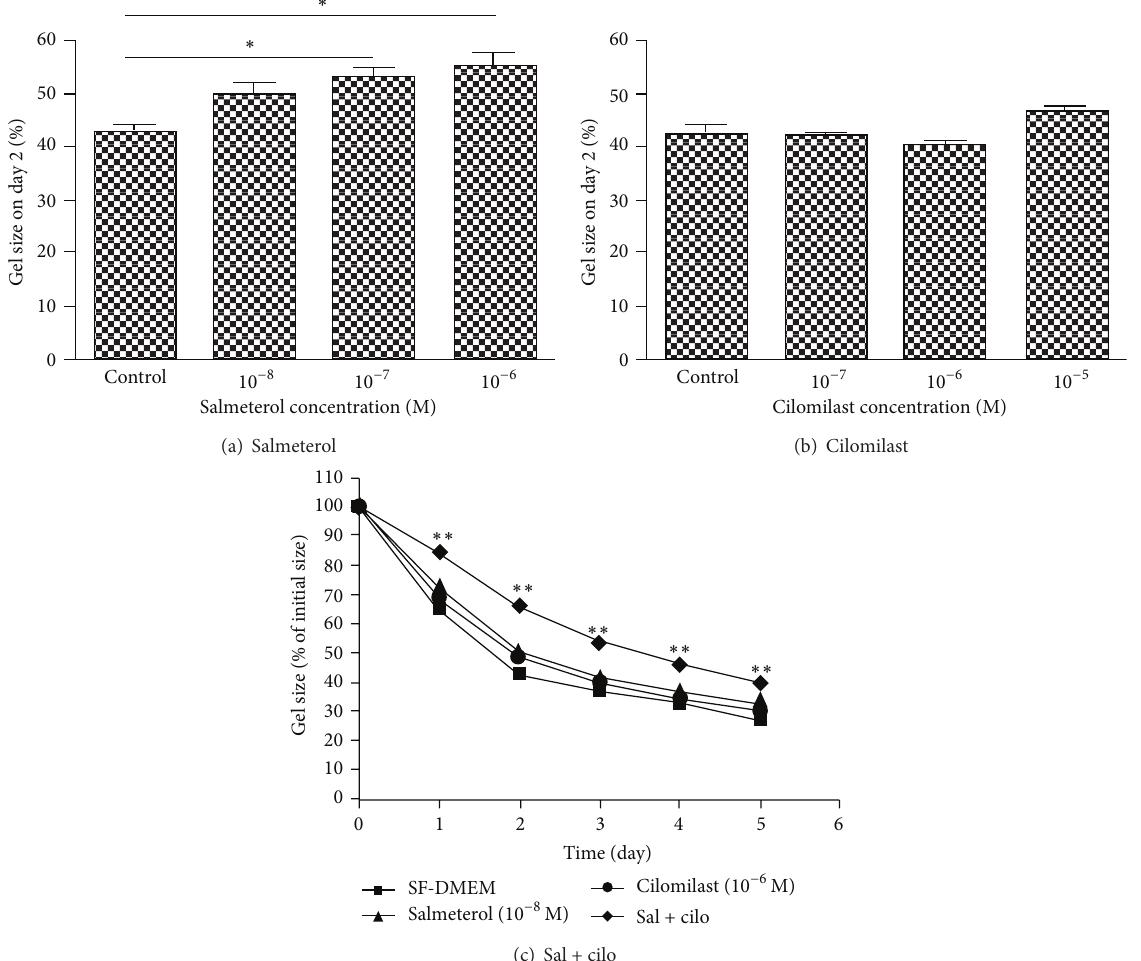
Figure 1: Synergistic effect of salmeterol and cilomilast on lung fibroblast-mediated collagen gel contraction. HFL-1 cells were cast into collagen gels and released into SF-DMEM containing either varying concentrations of salmeterol (0, 10 −8 , 10 −7 and 10 −6 M, (a)) or cilomilast (0, 10 −7 , 10 −6 , and 10 −5 M, (b)) as indicated. Gel size was measured on day 2. Vertical axes: gel size was expressed as percentage of initial size on day 2 (%); horizontal axes: concentrations of salmeterol or cilomilast. ∗ 𝑃 < 0.05 . (c) Synergistic effect of salmeterol and cilomilast are shown. HFL-1 cells were cast into collagen gels and released into SF-DMEM containing salmeterol (10 −8 M) and/or cilomilast (10 −6 M). Gel size was measured daily for 5 days. Vertical axis: gel size was expressed as percentage of initial size (%); horizontal axis: time (day). ∗∗ 𝑃 < 0.01 compared to SF-DMEM at each time